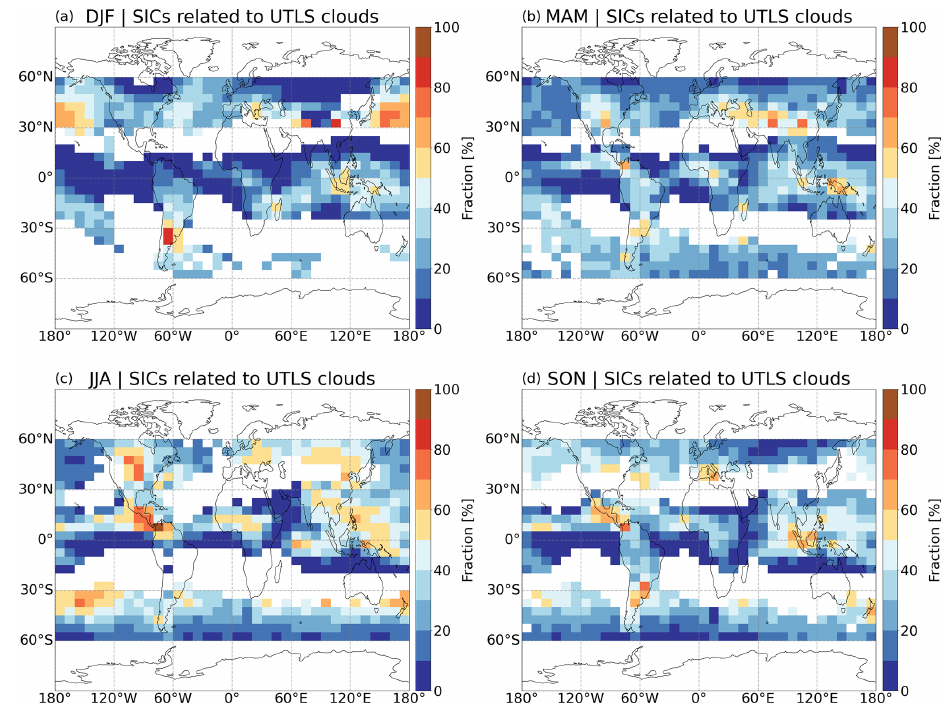
Figure 6. The fraction of SICs associated with UTLS clouds at the same local time